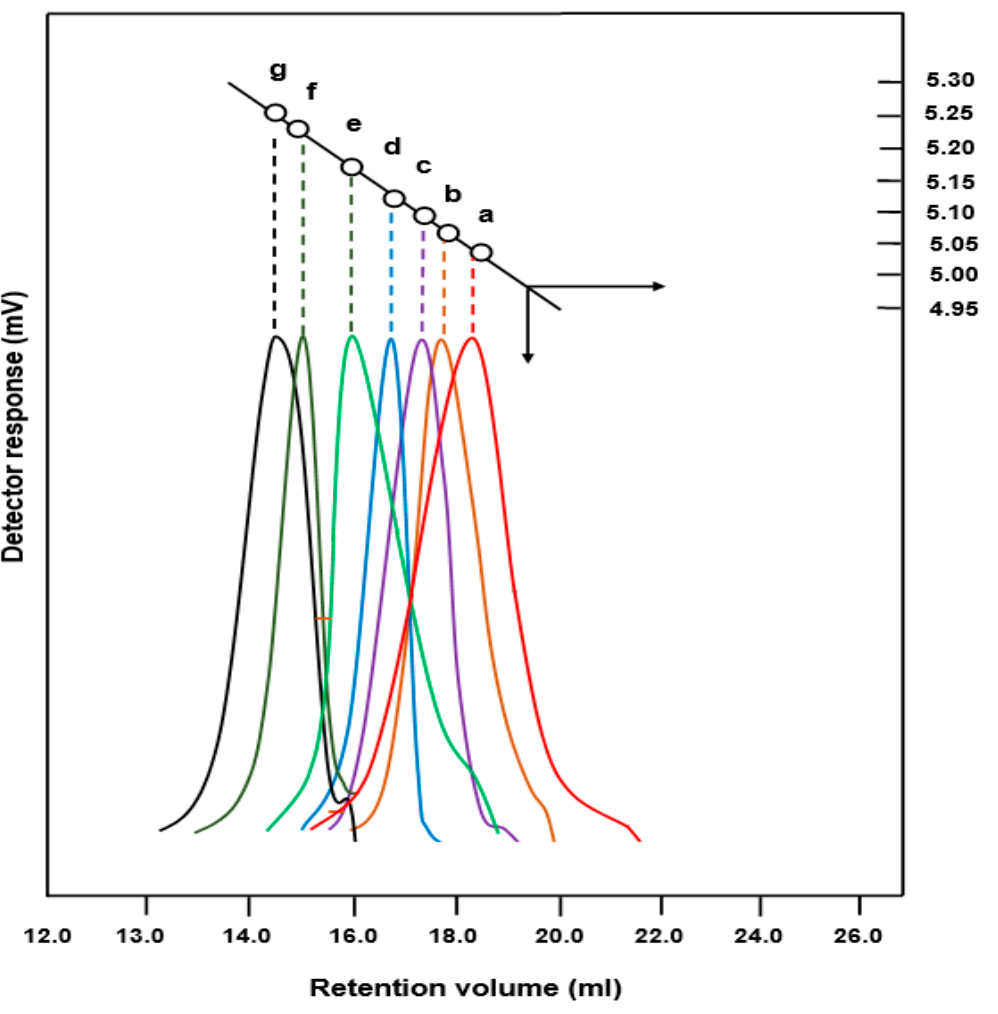
Figure 4. Size exclusion chromatography (SEC) chromatograms: (a) PEUGMA; (b) PMMA; (c) PEUGMA- co -MMA25; (d) PEUGMA- co -MMA35; (e) PEUGMA- co -MMA50; (f) PEUGMA- co -MMA65 and (g) PEUGMA- co -MMA75.